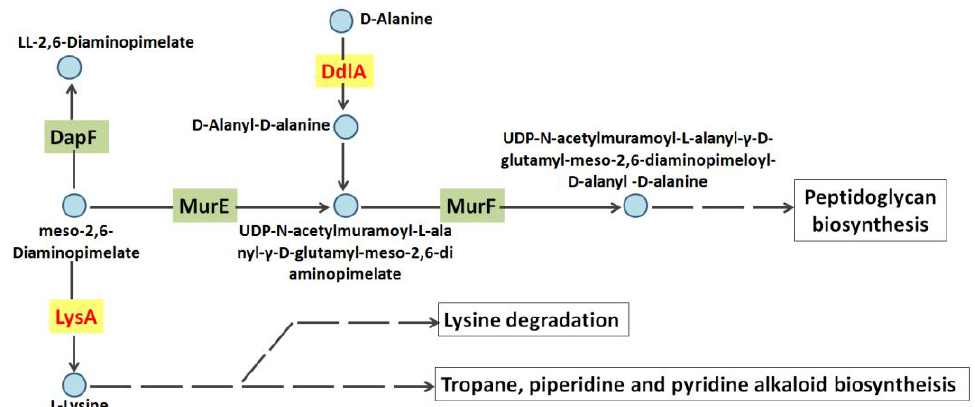
Figure 7. A view of metabolic pathway of DdlA and LysA leading to peptidoglycan biosynthesis. The pathway was summarized from the KEGG website (http://www.kegg.jp/kegg-bin/highlight_pathway?scale=1.0&map=mtu00300&keyword=lysA and http://www.kegg.jp/kegg-bin/highlight_pathway?scale=1.0&map=mtu01502&keyword=ddlA). Single lines represent the proceeding individual biosynthesis pathway catalyzed by the highlighted gene products. Dashed lines represent a series of successive biosynthesis pathways. Round nodes displayed metabolite intermediates. The genes associated with individual reaction were highlighted in grey color.